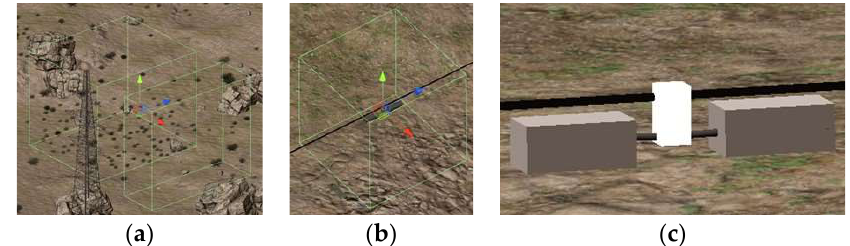
Figure 1. Virtual scenario processing: ( a ) Camera movement area; ( b ) movement area of the photography center; ( c ) the smallest outer rectangular body.